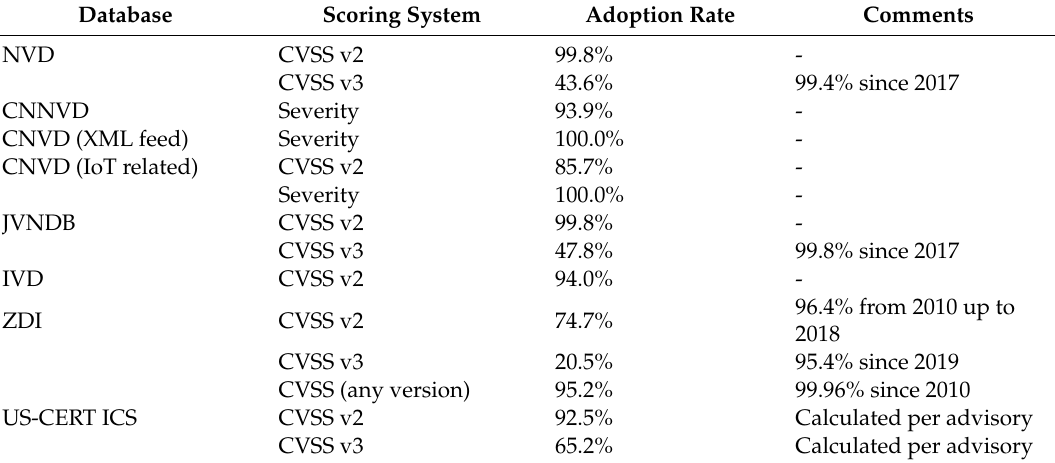
Table 13. Vulnerability scoring systems and their adoption rates across the sources. The percentages for severity are omitted in most cases, since this rating is derived from the CVSS score. The exception is made for CNNVD, which does not show CVSS scores and CNVD, which shows severity even for sources without CVSS